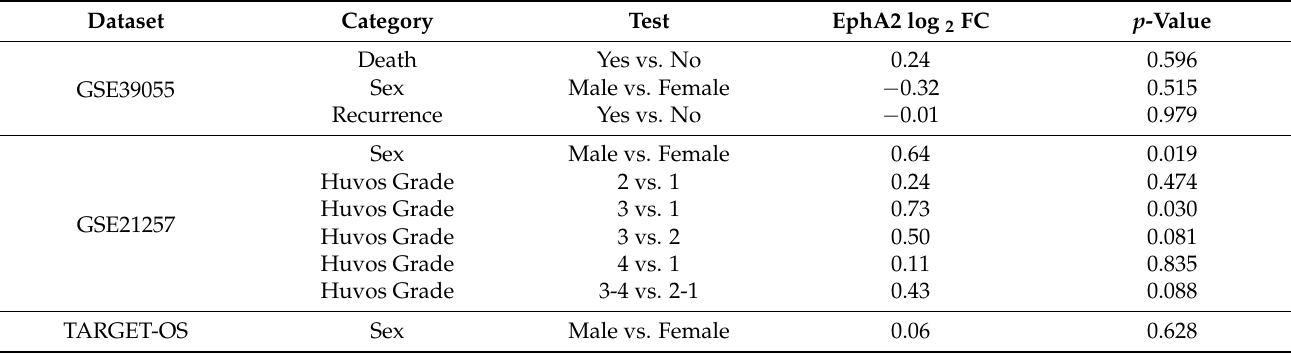
Table 2. Correlation of EphA2 expression level (Log2FC) with patient gender, Huvos grade, outcome and recurrence in